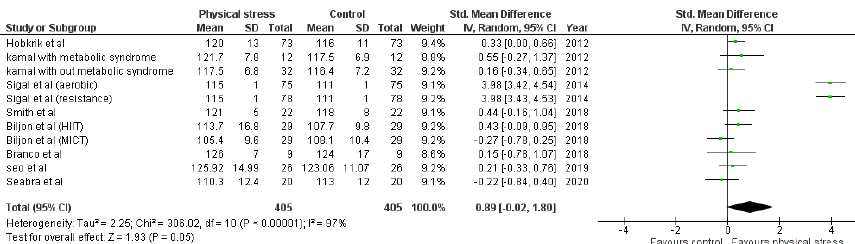
Figure 5. Forest plot showing the results for SBP.